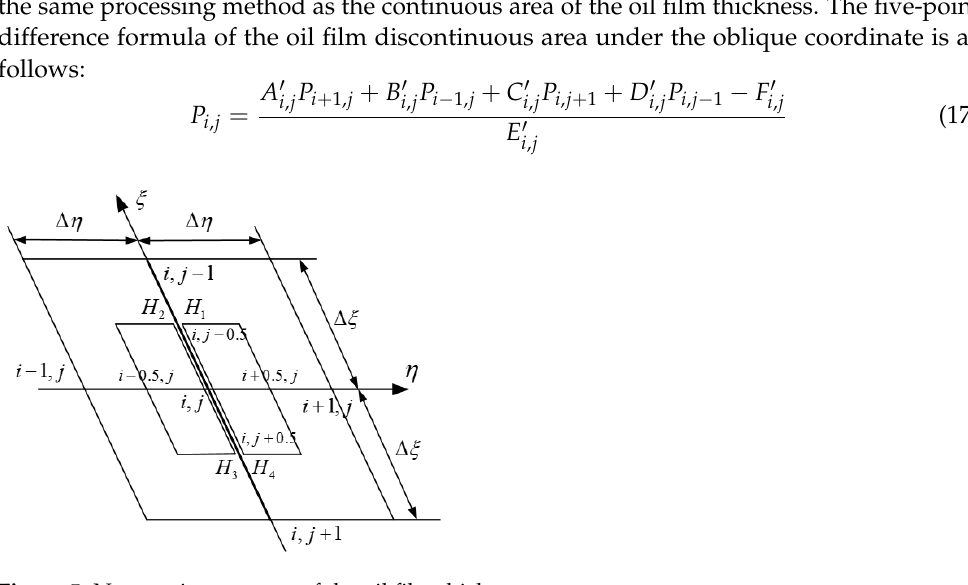
Figure 5. Noncontinuous area of the oil film thickness.